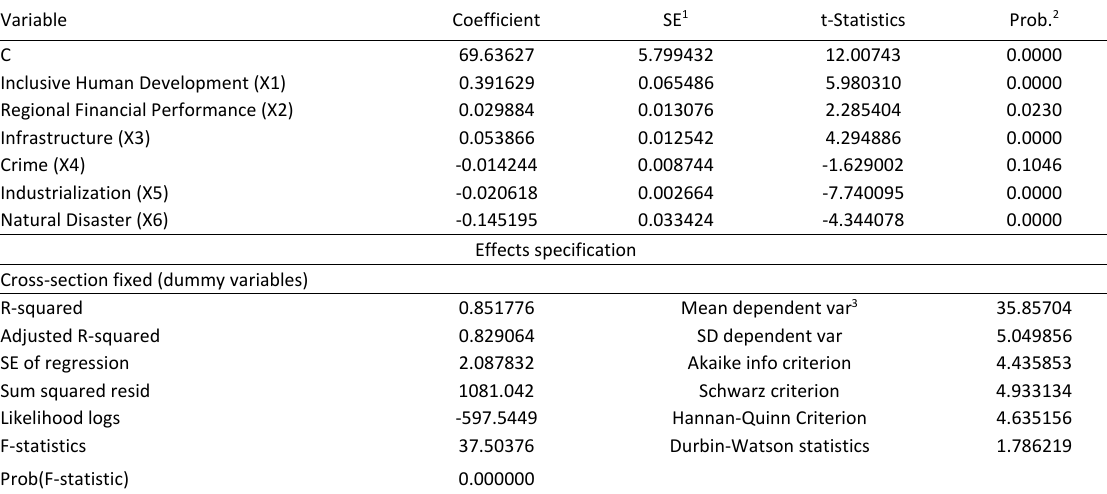
Table 3: Results of analysis of inclusive green growth variables (Y)